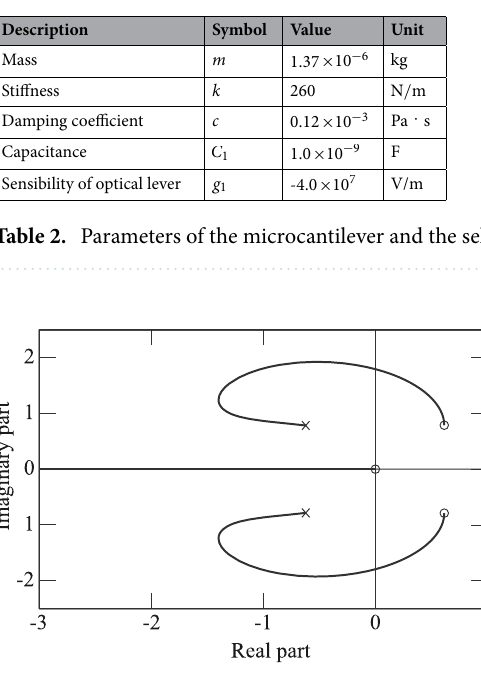
Figure 11. Root locus of the self-excited